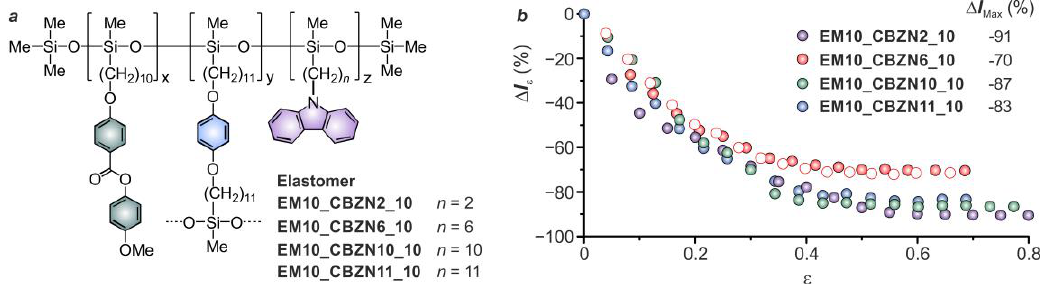
Figure 6. Chemical composition ( a ) and mechanofluorescent response ( b ) for the smectic LSCEs EM10_CBZN2_10, EM10_CBZN6_10, EM10_CBZN10_10 and EM10_CBZN11_10. The red empty circles indicate the mechanofluorescent response of elastomer EM10_CBZN10_10 at 328 K, i.e., within the thermal range of stability of its smectic A mesophase [59]. (Copyright from Wiley-VCH Verlag GmbH & Co. KGaA 2018).